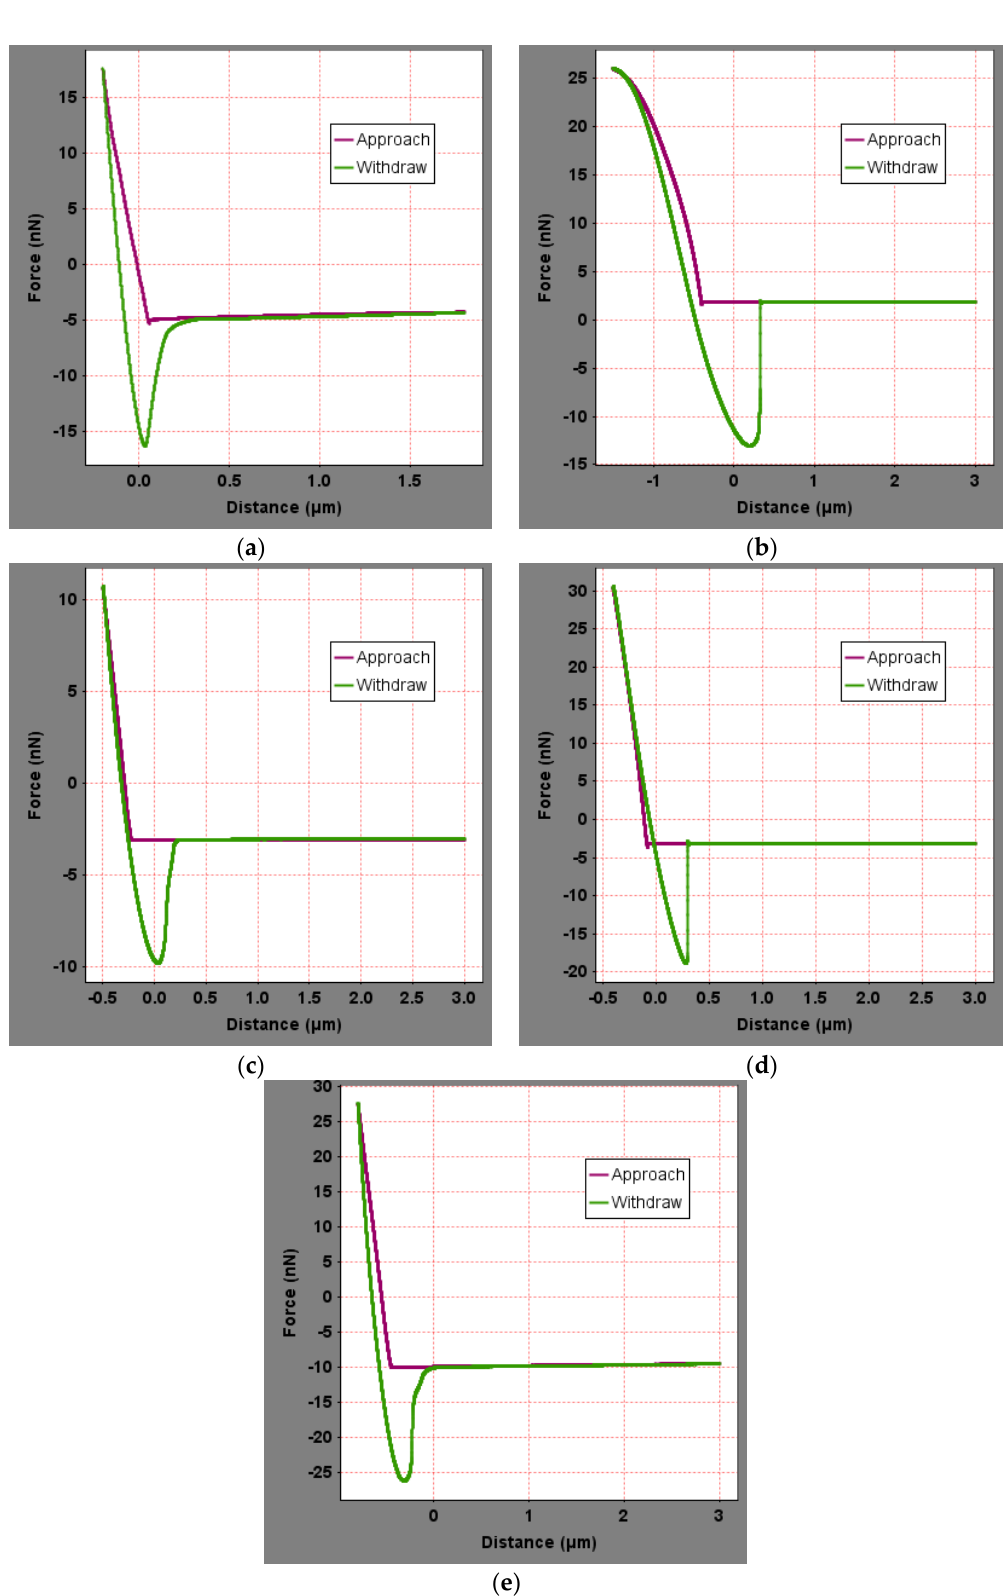
Figure 8. Force curves of the peak region of the bee-like structures in asphalts: ( a ) SK-70; ( b ) SK-90; ( c ) KL-70; ( d ) Shell-70; and ( e ) SBS-modified.